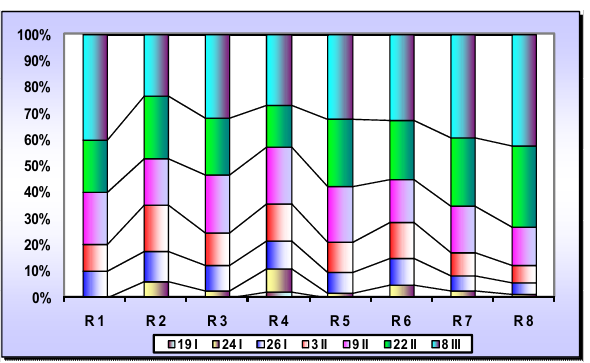
Fig. 3.Percentage of growth of the branches